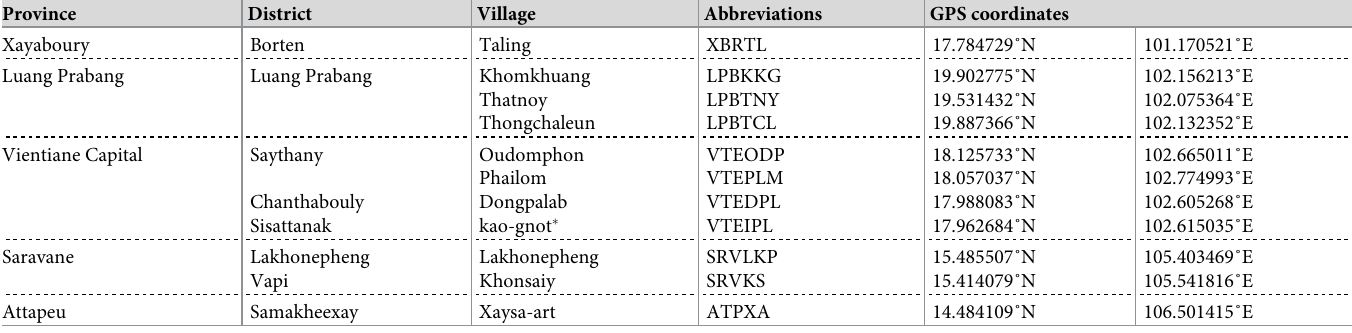
Table 1. List of the Aedes aegypti populations collected from the north to the south and their GPS coordinates. Population abbreviation names are used throughout the text.